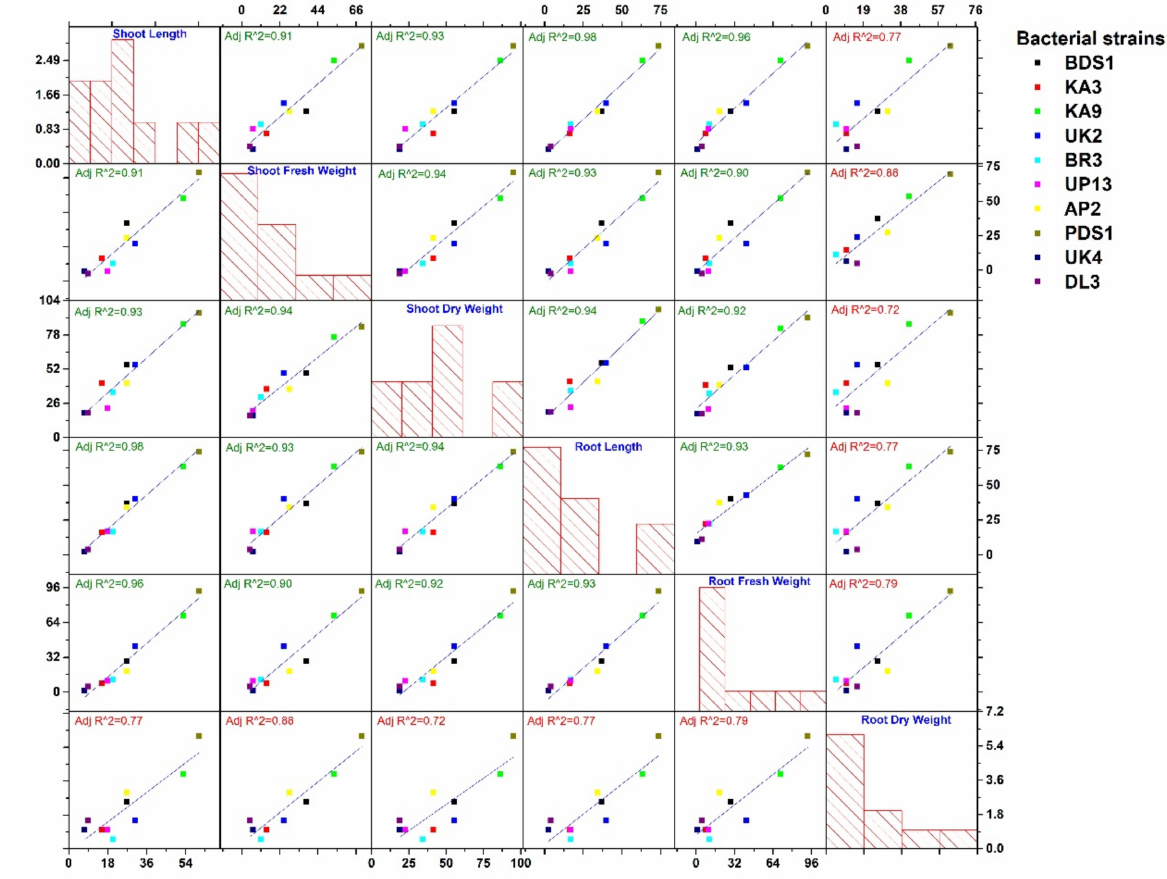
Figure 7. Growth-promotion efficiency of rhizobacteria strains on various growth parameters of chilli and regression